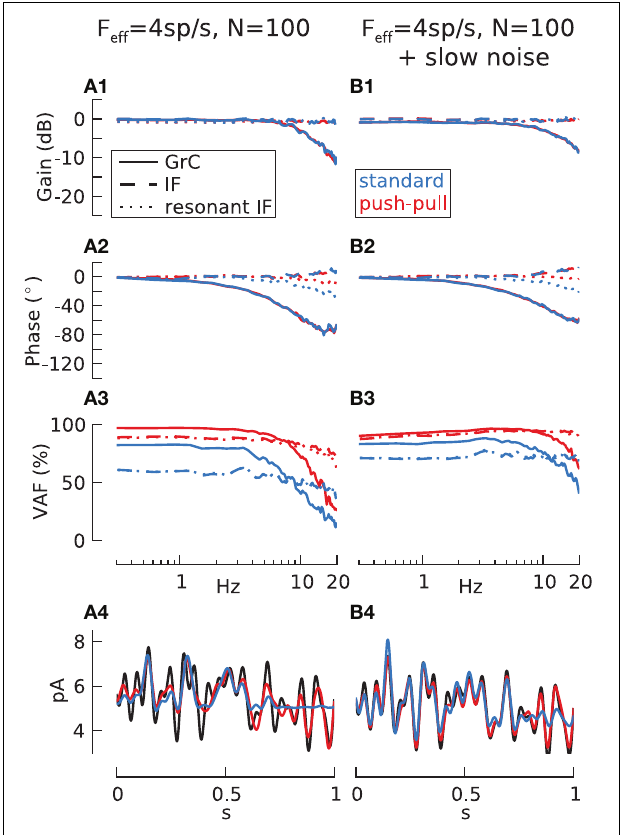
FIGURE 5 | Transmission with low firing-rate. Transfer function gain (A1,B1) , phase (A2,B2) , VAF (A3,B3) and reconstruction sample (A4,B4) for 100 cell populations of passive IF (dashed lines), resonant IF (rIF) (dotted lines) and GrC model (solid lines) without (A) and with (B) additive filtered slow noise ( τ n = 100ms). In addition to the normal case where population is encoding the whole signal (blue lines) push-pull coding (red lines) is shown. In this case, half of the cells encode only the positive and the negative part of the signal respectively. Input current adjusted for all recordings to result in m ( F eff ) = 4 spikes/s and std ( F eff ) = 2 spikes/s. [ m ( VAF ) in % for IF/rIF/GrC: 50.9/50.8/46.4; 82.5/80.1/68.3 (push-pull); 72.0/73.1/72.4 (slow noise); 93.8/93.1/87.6 (push-pull + slow